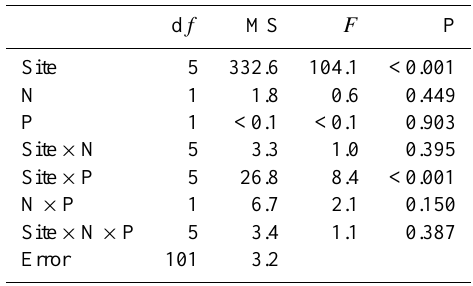
Table 2. Results of 3-way ANOVA of site, nitrogen (N), and phos- phorus (P) addition on the carbon stock in belowground seagrass tissue.